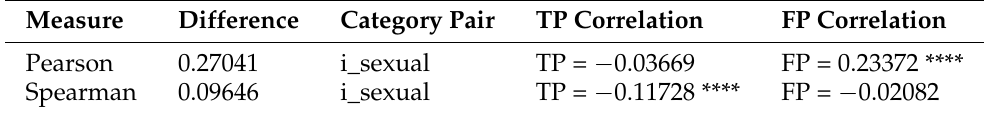
Table 33. 1st person pronoun and Sexual words in Medium.